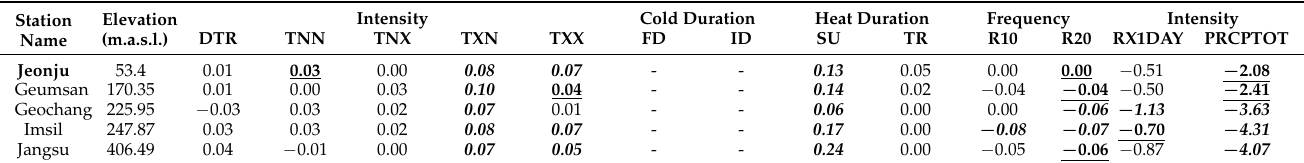
Table A12. Trend magnitudes for the month of June in the UGRB for 33 years (1988–2020).